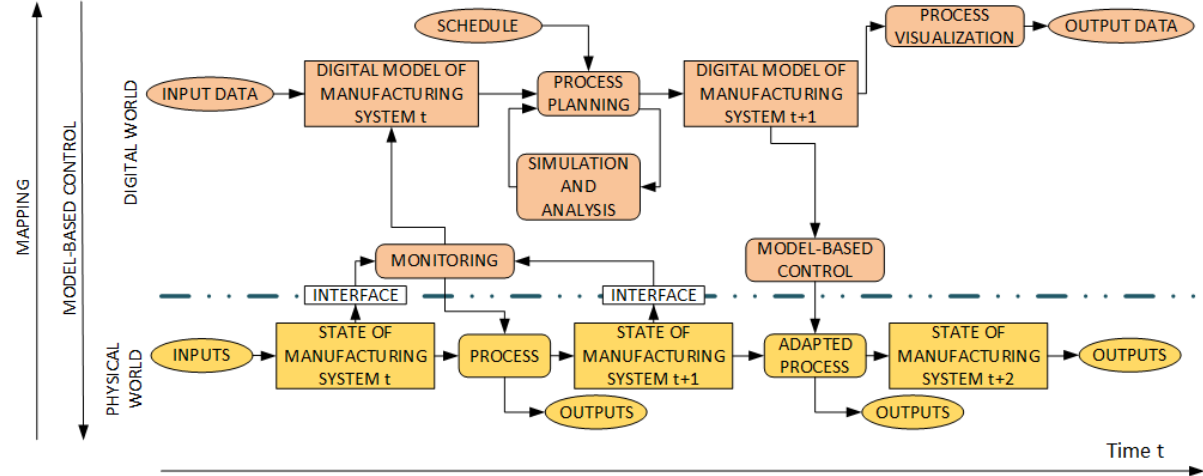
Figure 9. Position of the model and the connections between the physical and digital worlds.